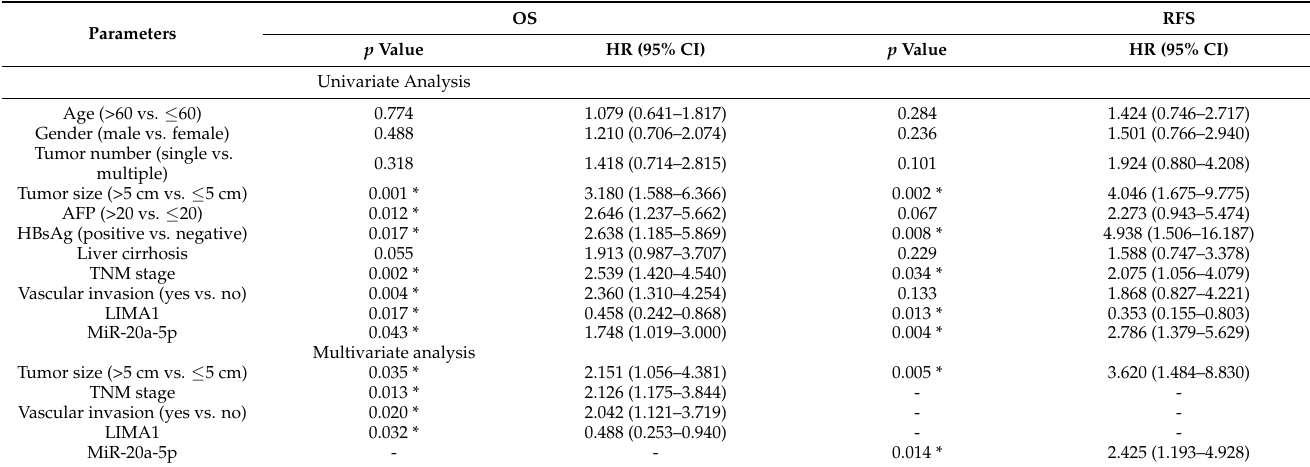
Table 2. The univariate and multivariate COX analysis for the prognostic impact of LIMA1 and miR-20a-5p.